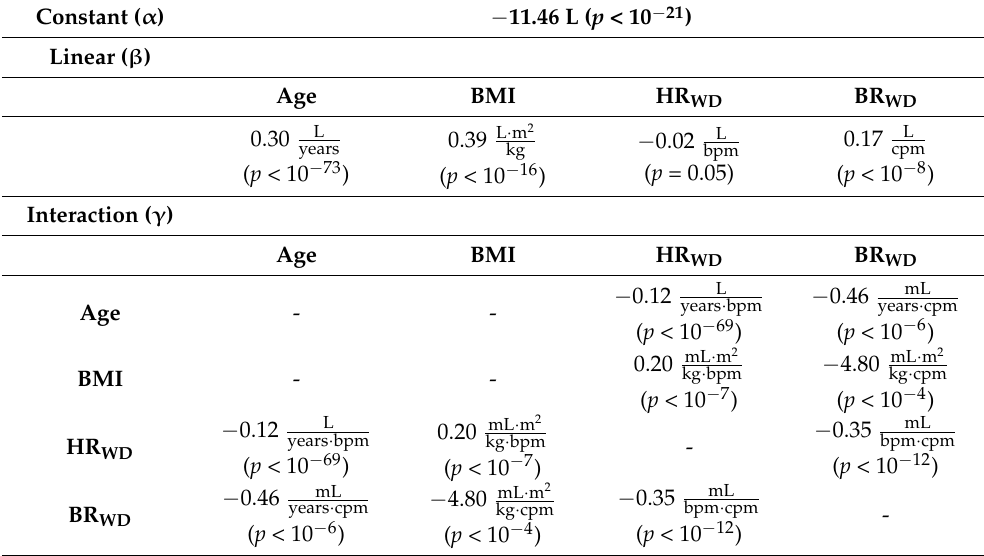
Figure 1. Bland–Altman plots for the comparison between: ( A ) prediction of tidal volume using wearable-device data ( TV WD ) and breath-by-breath tidal volume (TV); ( B ) prediction of tidal volume using reference instrumentation ( TV REF ) predictions and breath-by-breath TV; mean and limits of agreement (LoA) are reported, together with the related confidence interval (CI). Linear regression analysis for the comparison between: ( C ) prediction of tidal volume using wearable-device data ( TV WD ) and breath-by-breath tidal volume (TV); ( D ) prediction of tidal volume using reference instrumentation ( TV REF ) and breath-by-breath TV; correlation coefficient is reported (ρ), together with statistical significance (* indicates p < 0.05). Table 4. Values of the model parameters obtained by applying the stepwise linear regression approach with interactions.